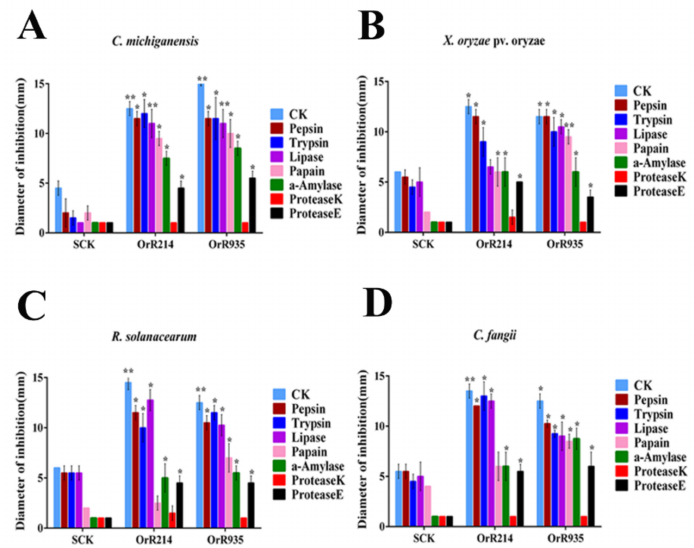
Figure 4. Stability tests of antimicrobial peptides. Inactivation of the antimicrobial activity of two peptides, OrR214 and OrR935, was tested by di ff erent biological enzymes. The SCK6-e B. subtilis strain was used as a control, and stabilities were tested against four indicator bacteria. ( A ) ( C. michiganensis ), ( B ) ( X. oryzae pv. oryzae), ( C ) ( R. solanacearum ), and ( D ) ( C. fangii ) represent treatments with seven di ff erent kinds of biological enzymes, including pepsin, trypsin, lipase, papain, α -amylase, peptidase K, and protease E. The data represent the average of three separate experiments. T -tests were conducted for significance analysis at * p ≤ 0.05 and ** p ≤